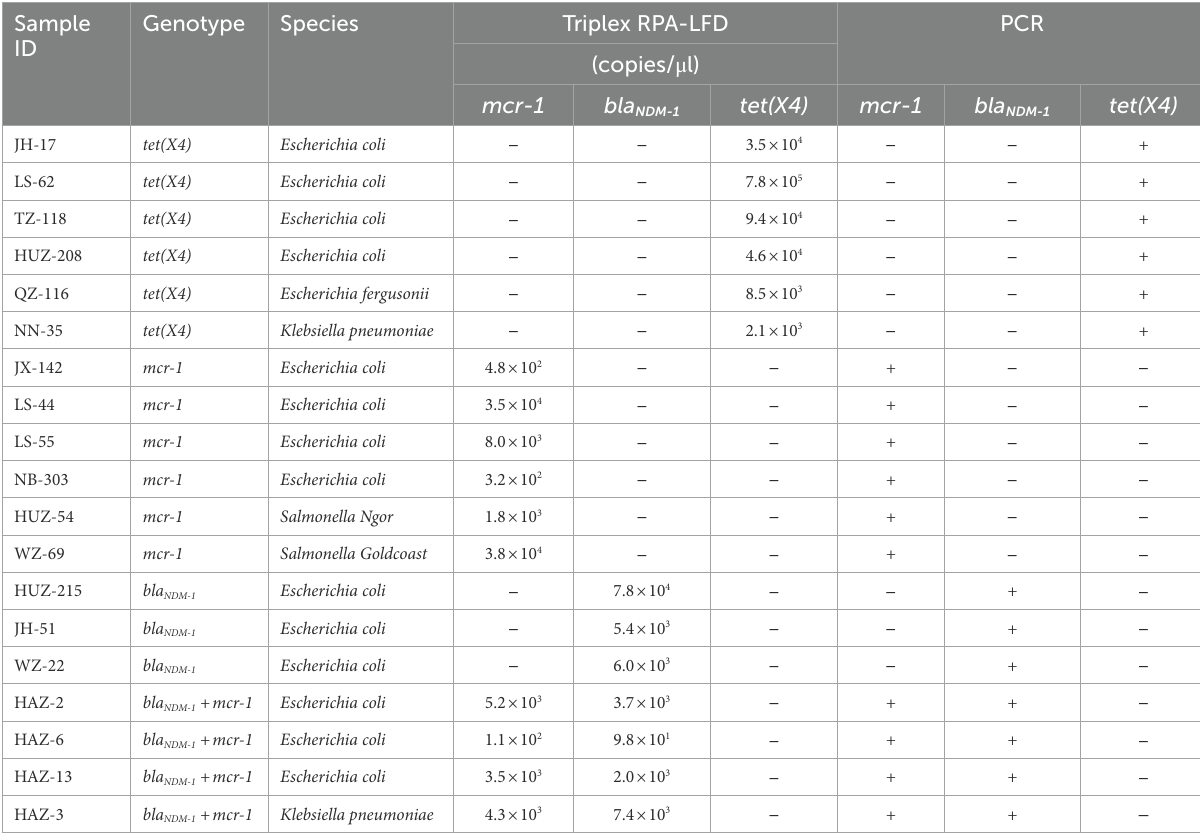
TABLE 2 Application analysis of the triplex RPA-LFD assay and PCR method. Sample